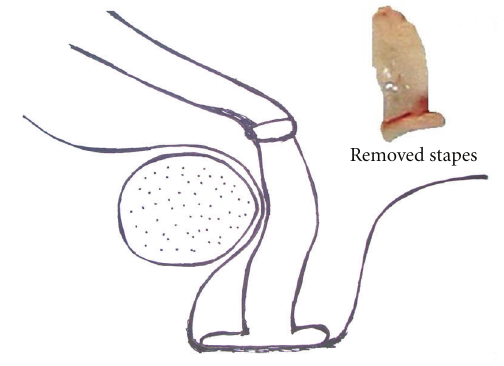
Figure 2: Schema of the right middle ear: stapes ankylosis, monop- odial stapes with small footplate and facial canal displaced anterior- ly. Removed stapes in the upper right-hand side of the picture.